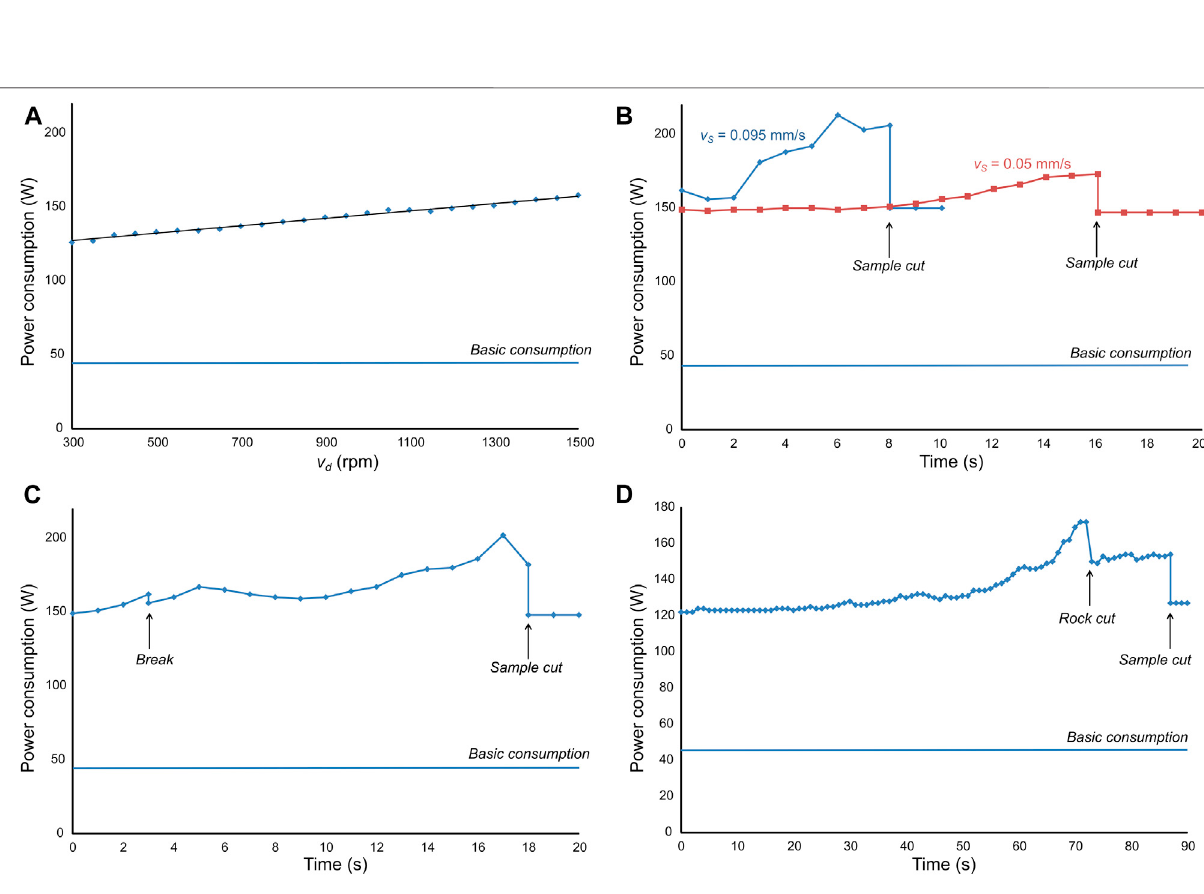
Frontiers in Astronomy and Space Sciences |